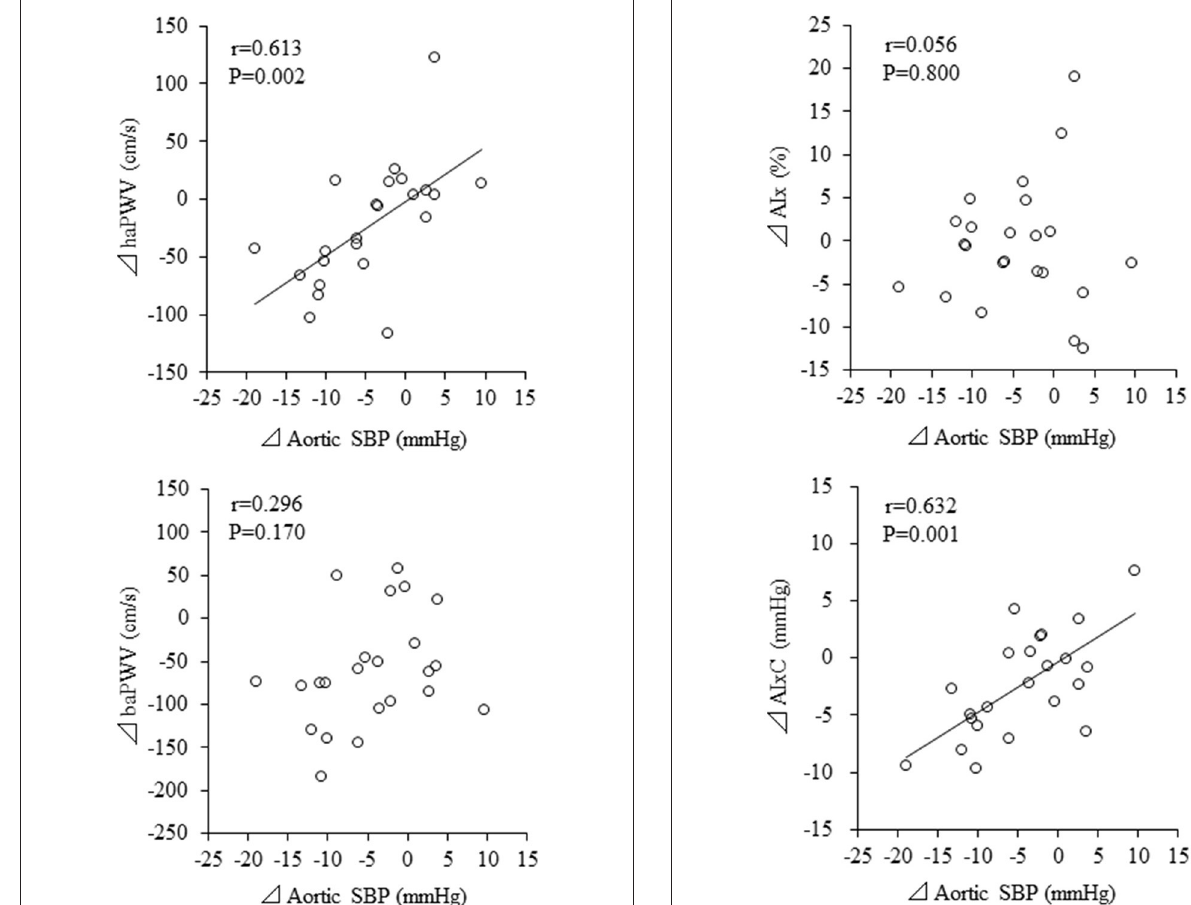
FIGURE 4 | Correlations between changes in pulse wave velocity (PWV) and aortic systolic blood pressure (SBP). baPWV, brachial-ankle PWV; haPWV, heart-ankle PWV.